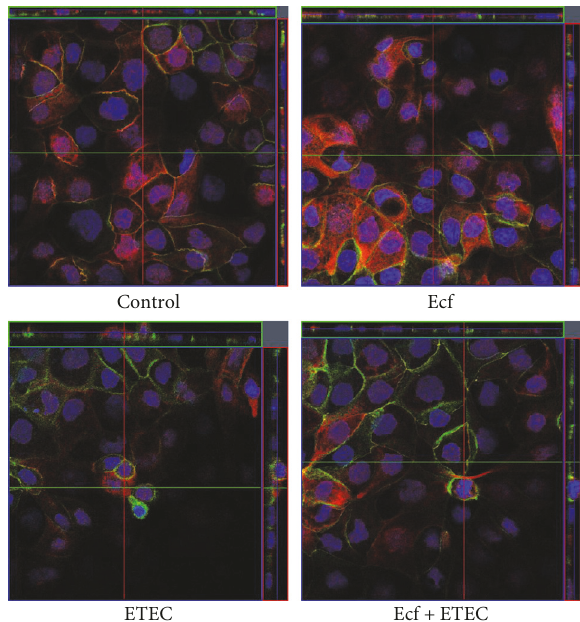
Figure 5: Confocal images of postcon fl uent IPEC-J2 cells 6h after treatment with bacterial strains (Ecf, ETEC, and Ecf +ETEC) and controls (red: occludin, green: claudin-4). N = 5 independent